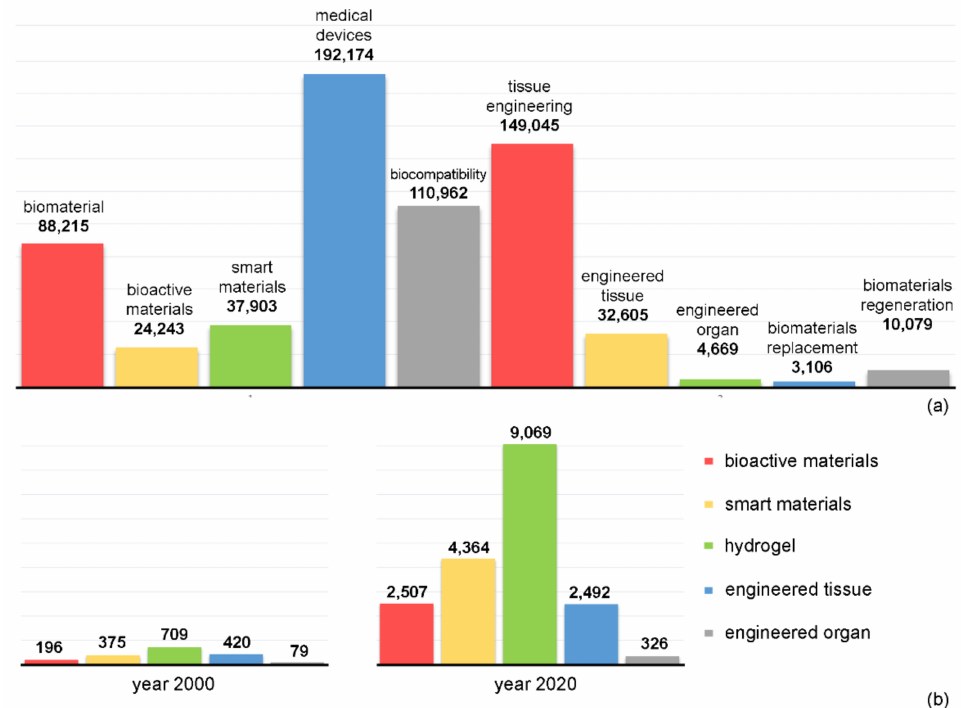
Figure 3. Cumulative number of Scopus records for different keywords related to biomaterials, up to June 2021 ( a ); comparison of the number of records in years 2000 and 2020 for selected keywords ( b